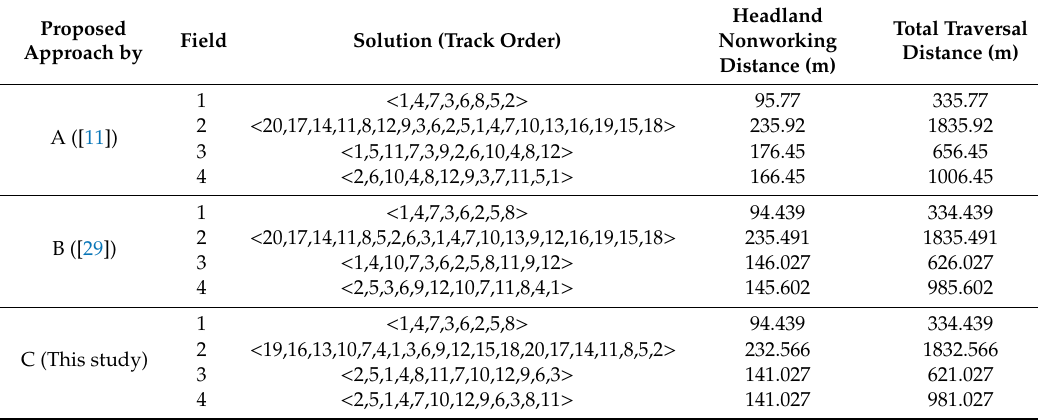
Table 3. Comparison of the generated solutions based on the proposed method in this study with the results provided in studies [11] and [29]. ( A ) Method proposed in [11], ( B ) method proposed in [29], and ( C ) method proposed in this